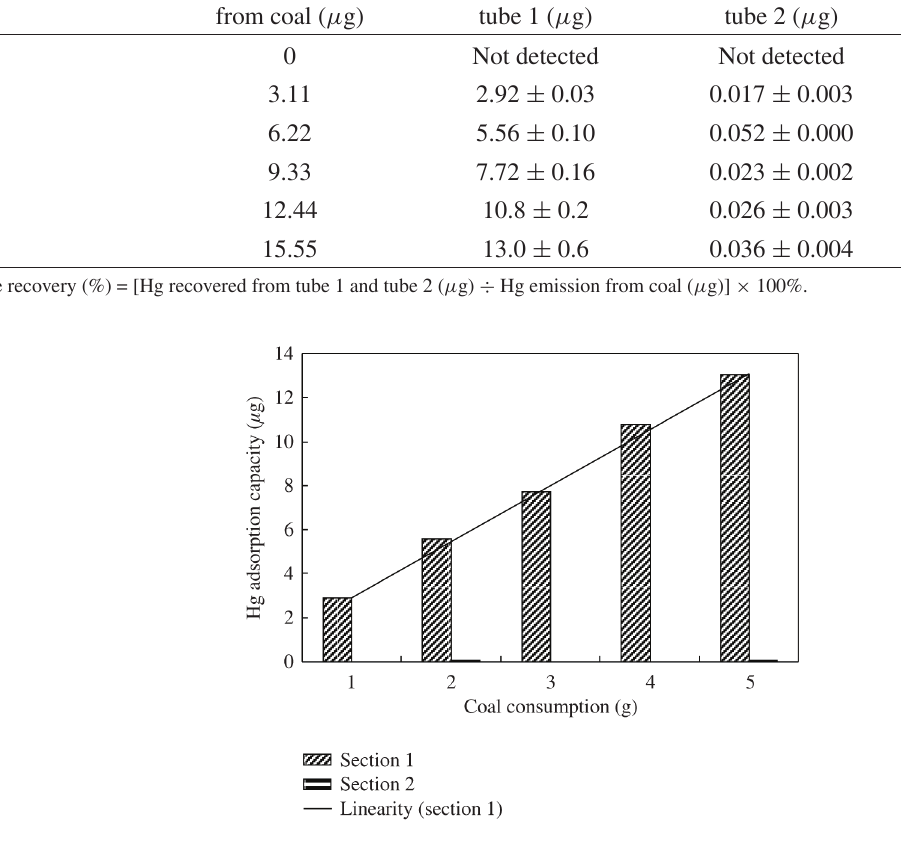
FIGURE 6: Distribution of Hg in tube 1 and tube